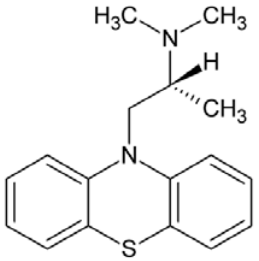
Figure 1. Structure of